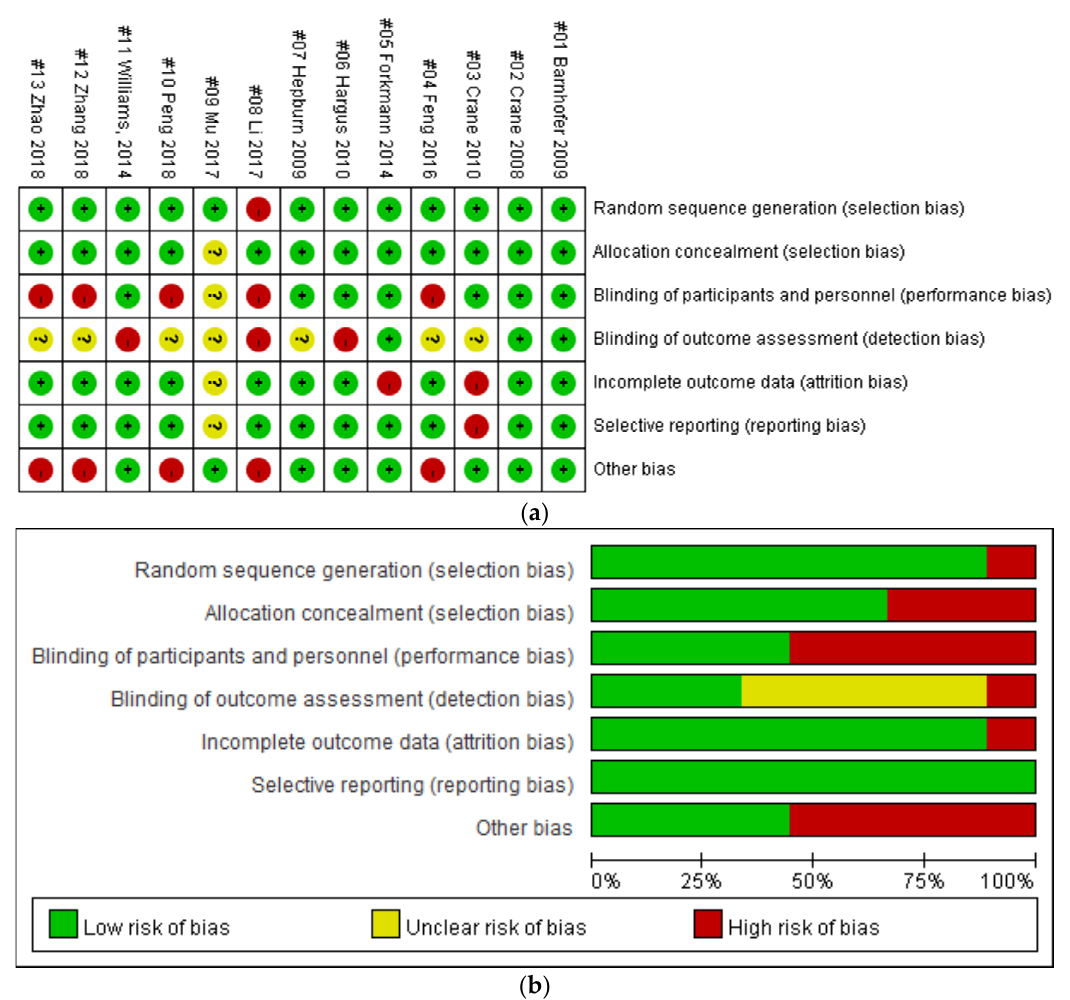
Figure 2. Risk of bias assessment: review authors’ judgments about each risk of bias item, presented as percentage of included studies. ( a ) Risk of bias summary. ( b ) Risk of bias graph (color figure can be viewed at wileyonlinelibrary.com accessed in 1 December 2022).